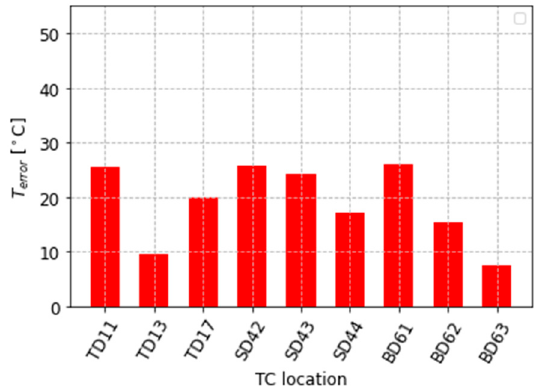
Figure 9. Error between the model and measured data.